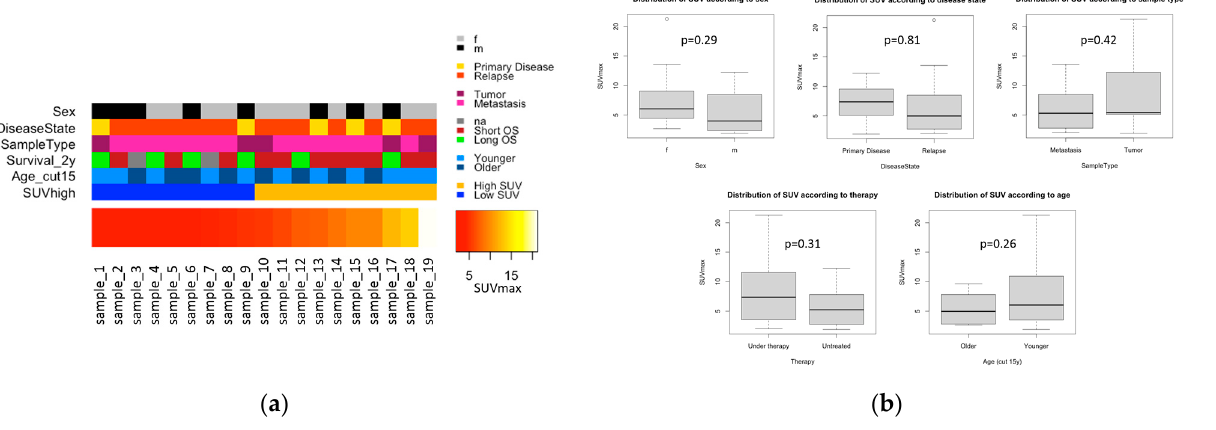
Figure 2. Clinical data. ( a ) 19 EwS samples ordered by increasing SUVmax having a range of 1.9 to 21.3 (bottom). On top, additional clinical information is provided about sex (female or male), disease state (primary disease or relapse), sample type (tumor or metastasis), 2-year overall survival (OS), age ( ≤ 15 years or >15 years), and categorical partitioning of the samples into high SUV or low SUV (split by median SUVmax). ( b ) Boxplots showing distribution of SUVmax values with regard to clinical variables: sex (female or male), disease state (primary disease or relapse), sample type (tumor or metastasis), therapy (under therapy or untreated), and age ( ≤ 15 years or >15 years). p -Values from the Welch two-sample t